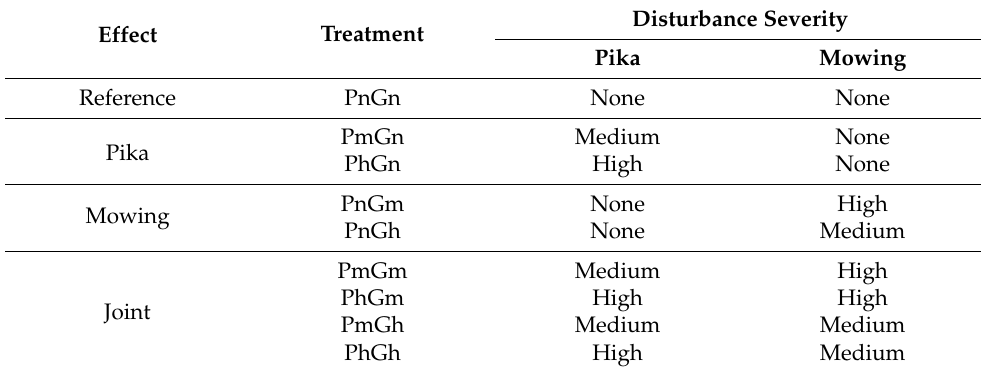
Figure 2. Images of the study site showing the experimental area with its weather station ( a ) and the above/below ground characteristics of the plot fencing ( b ). above/below ground characteristics of the plot fencing ( b ). Table 1. Information about the treatments. Table 1. Information about the